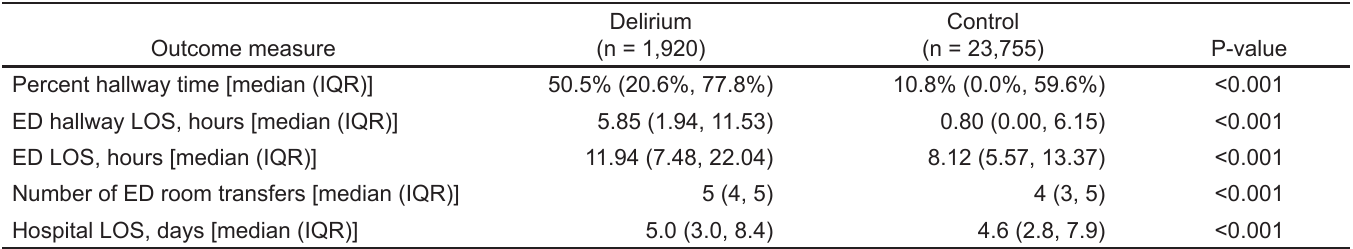
Table 4. Length of stay comparisons between the delirium and control groups.